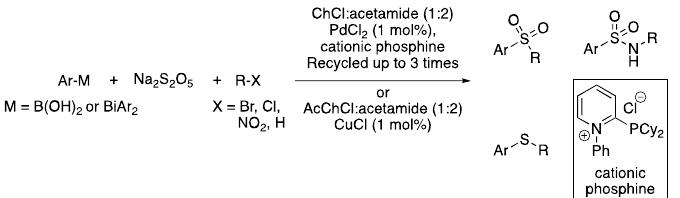
Figure 35. Multicomponent synthesis of sulfones, sulfides and sulfonamides.